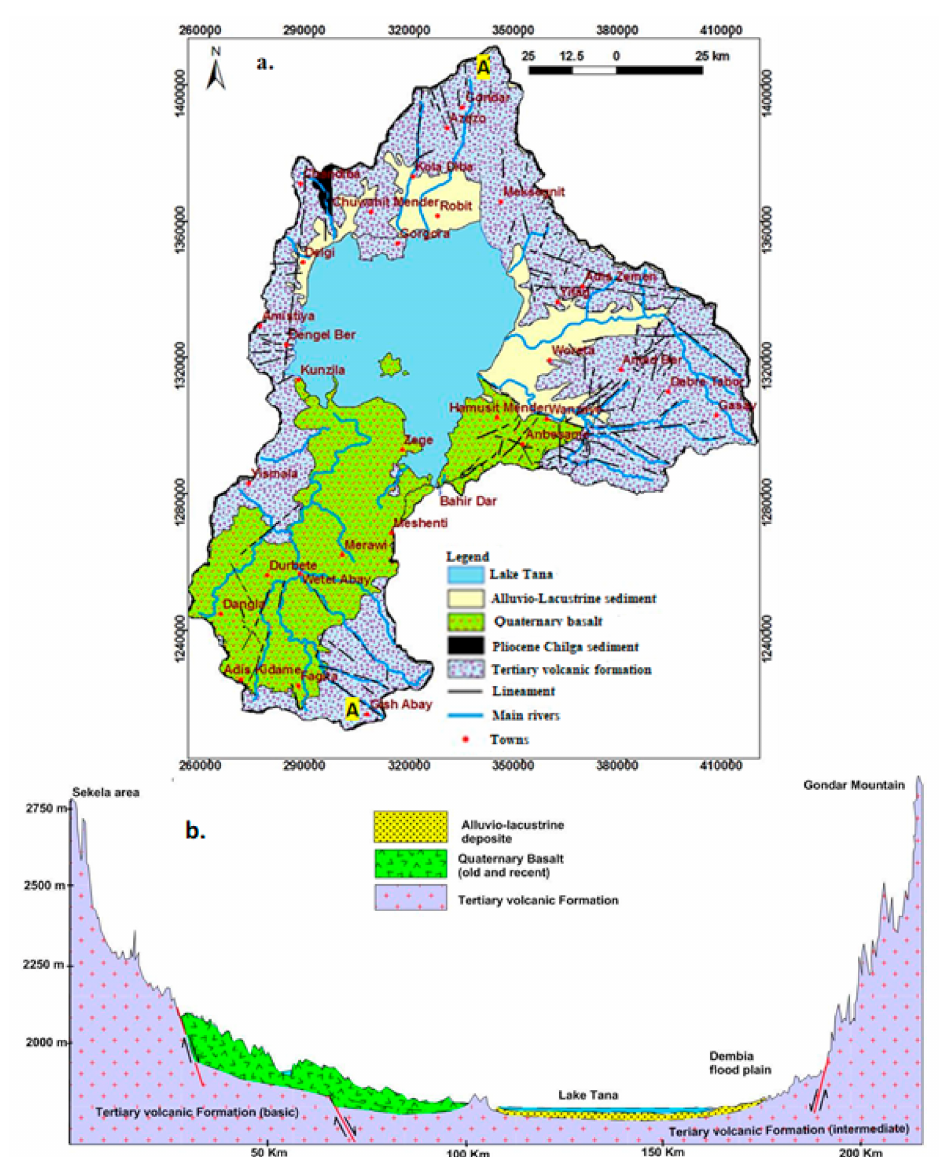
Figure 3. Geological map of Lake Tana Basin ( a ) and a cross-section from Sekela to Gondar mountain (A–A (cid:48) ) ( b ) modified after Nigate et al. [41], (2017). The UTM zone is 37P and the coordinate system is WGS